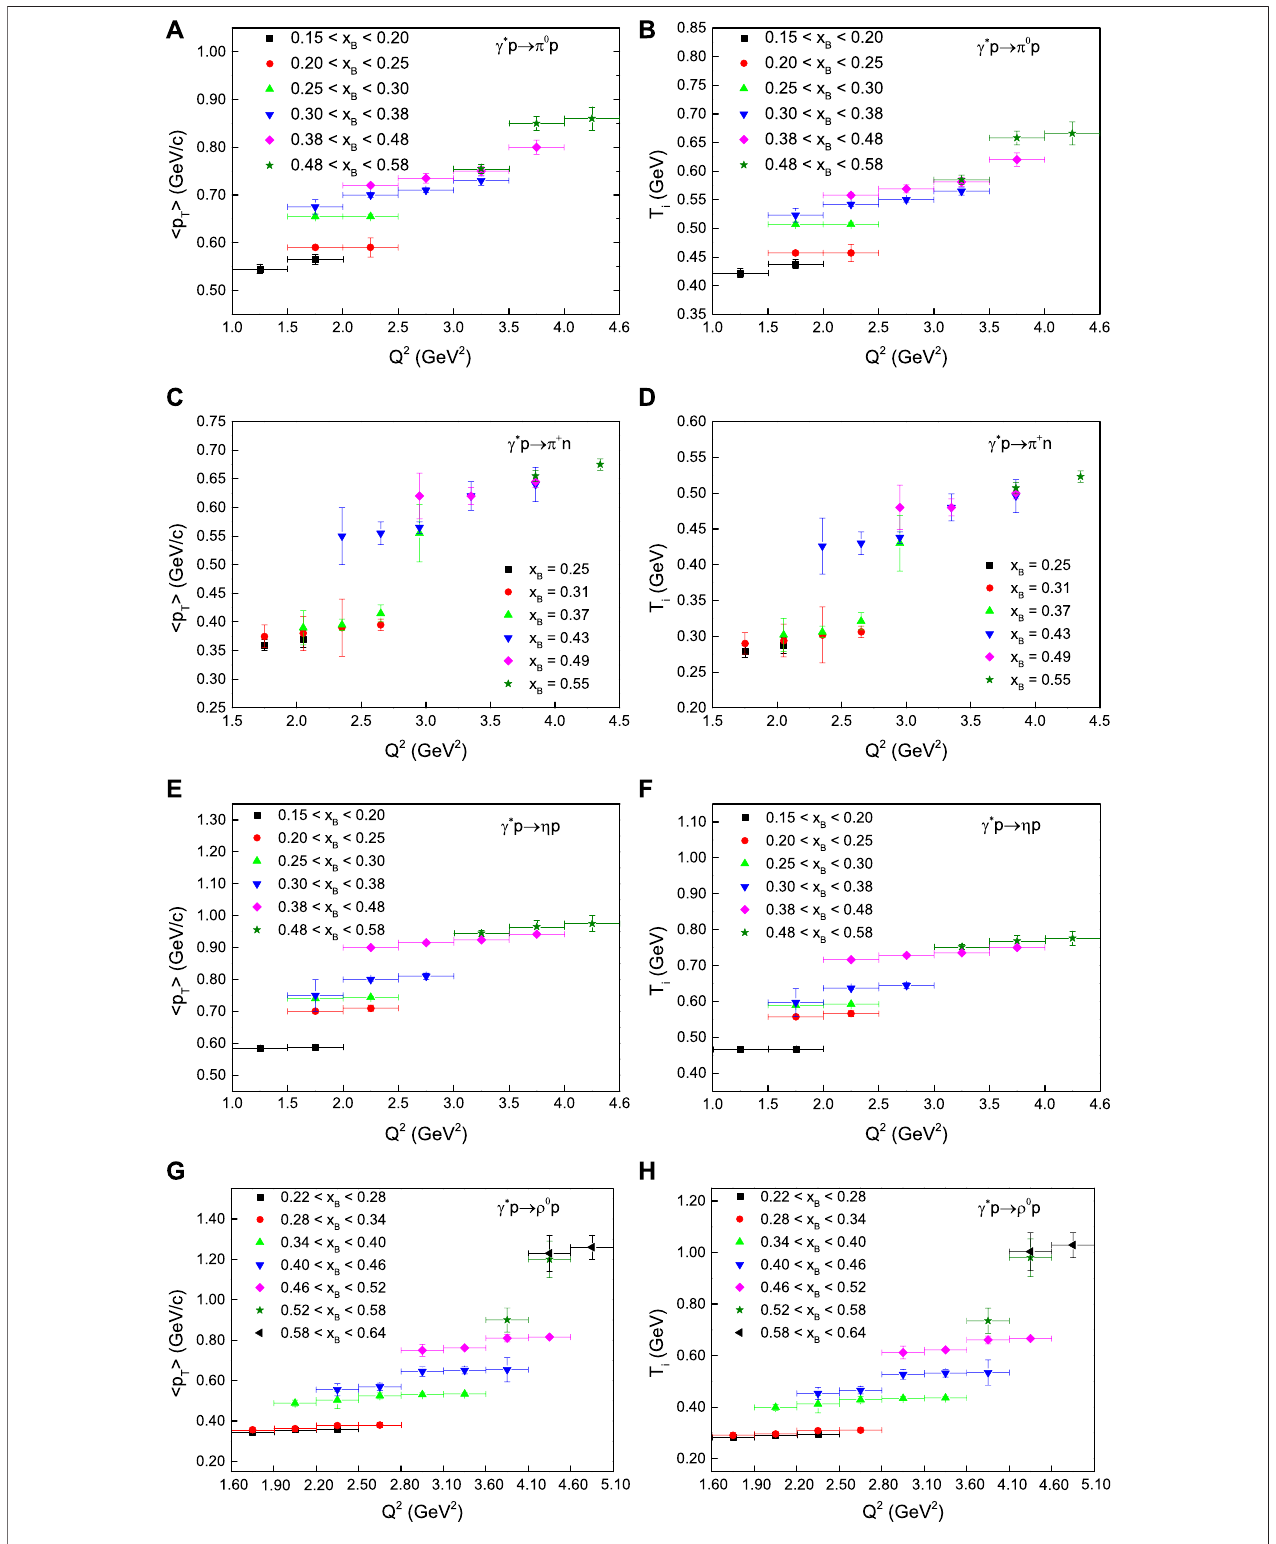
FIGURE 5 | The dependences of 〈 p T 〉 (A,C,E,G) and T i (B,D,F,H) on Q 2 in c * p collisions with emitted channels π 0 p (A,B) , π + n (C,D) , η p (E,F) , and ρ 0 p (G,H) . Different symbols represent the results for different x B .